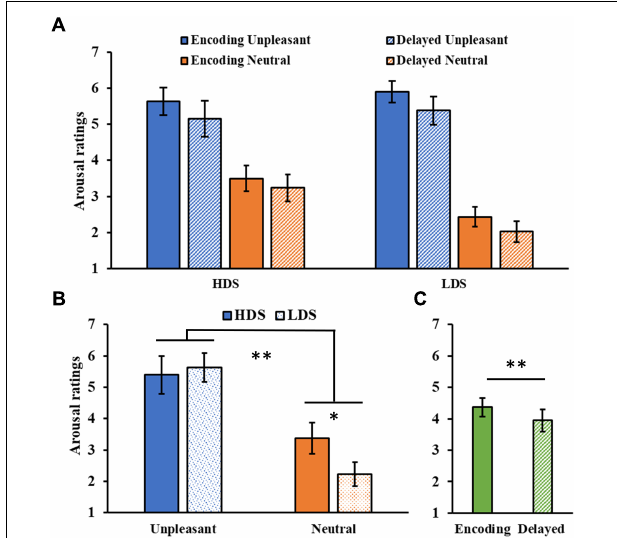
FIGURE 5 | (A) Arousal ratings as a function of the group and of the category of stimuli (unpleasant and neutral pictures) at the encoding and at the delayed recognition sessions. (B) Group (HDS and LDS) × Category (unpleasant and neutral pictures) interaction for the arousal ratings. (C) Session (encoding and delayed recognition sessions) main effect for arousal ratings. LDS: participants with lower depression symptoms; HDS: participants with higher depression symptoms. Error bars represent standard error of the mean. ∗ p < 0.05; ∗∗ p < 0.01.